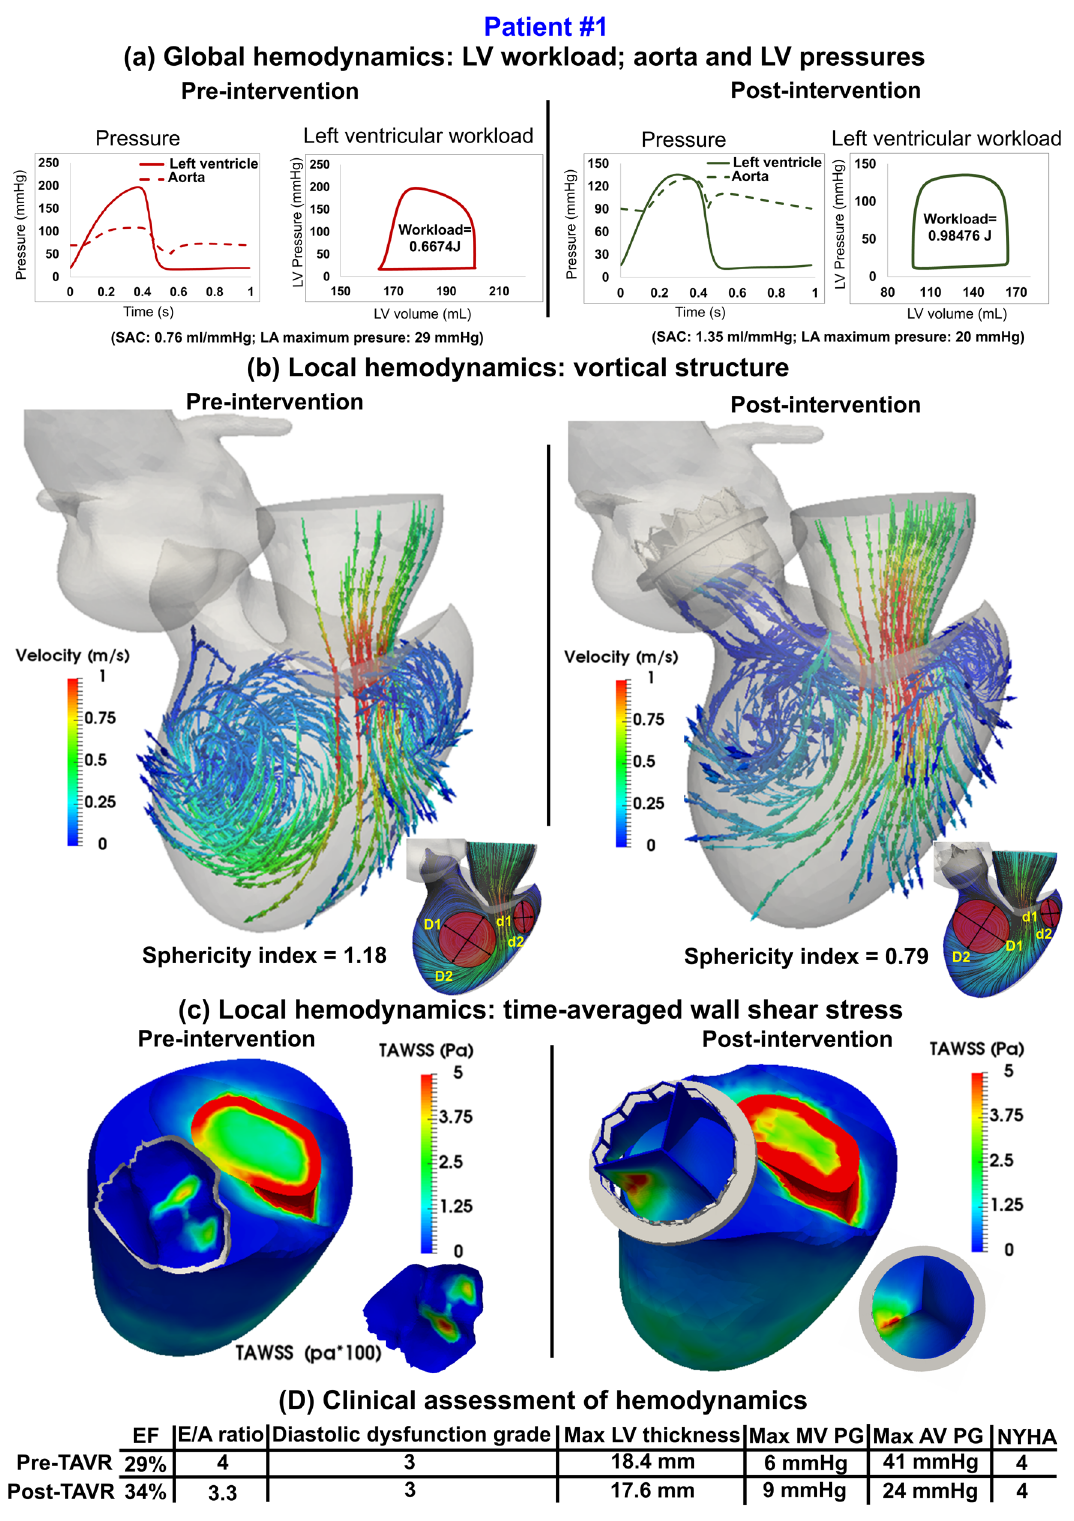
Figure 8. Changes in local and global hemodynamics in patient #1 between baseline and 90-day post-TAVR. ( a ) Global hemodynamics : LV workload, aorta and LV pressures; ( b ) Local hemodynamics : vortical structure; ( c ) Local hemodynamics : time-averaged wall shear stress; ( d ) Clinical assessment of hemodynamics. Local hemodynamics: cardiac fluid dynamics , e.g., details of the instantaneous 3-D flow and vortex formation. Global hemodynamics: (1) Metrics of circulatory function , e.g., detailed information of the dynamics of the circulatory system, and (2) Metrics of cardiac function , e.g., heart workload and the breakdown of workload contributions from each cardiovascular disease